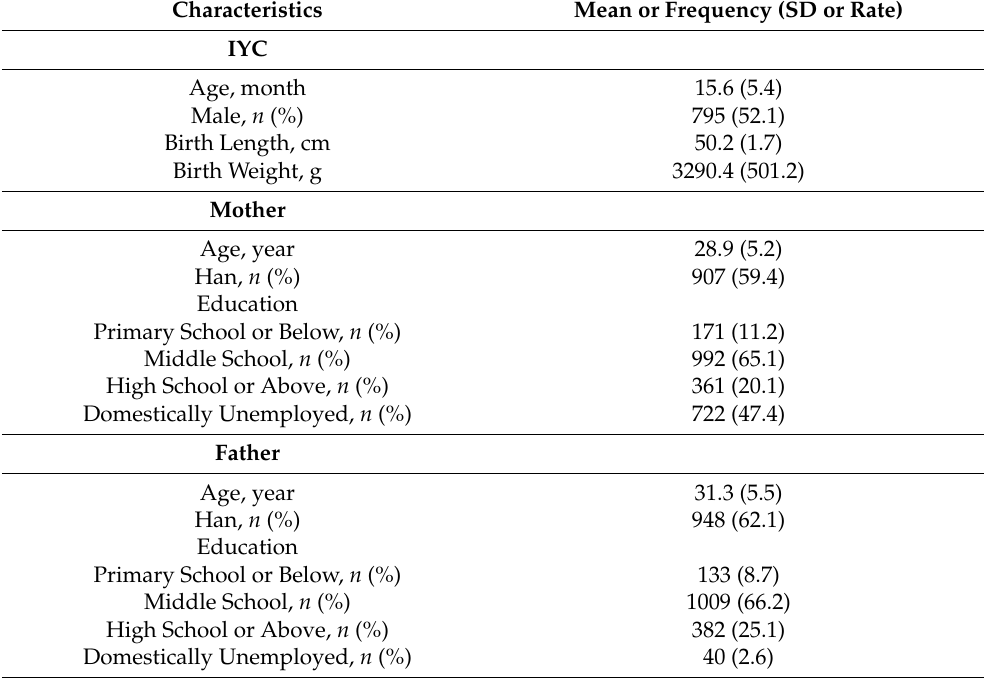
Table 1. Basic demographic